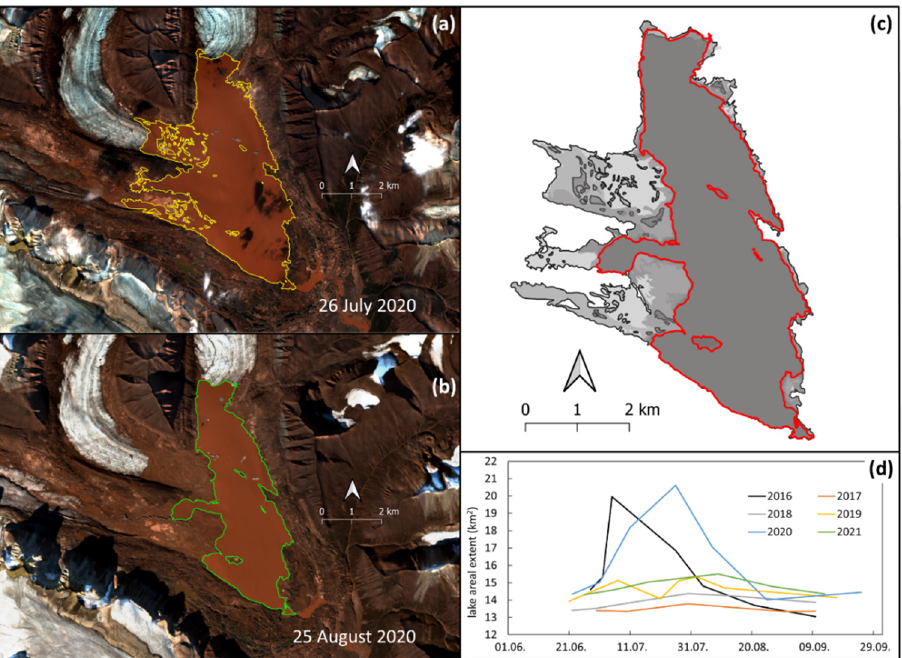
Figure 5. Seasonal dynamics of Trebrevatnet areal extent; examples of ( a ) maximum and ( b ) minimum areal extent from 26 July 2020 and 25 August 2020 respectively; ( c ) the areal extent variability expressed as overlapping lake extent during the 2020 summer season with minimum highlighted in red and maximum in black; ( d ) comparison of the seasonal lake areal extent evolution within the studied years.